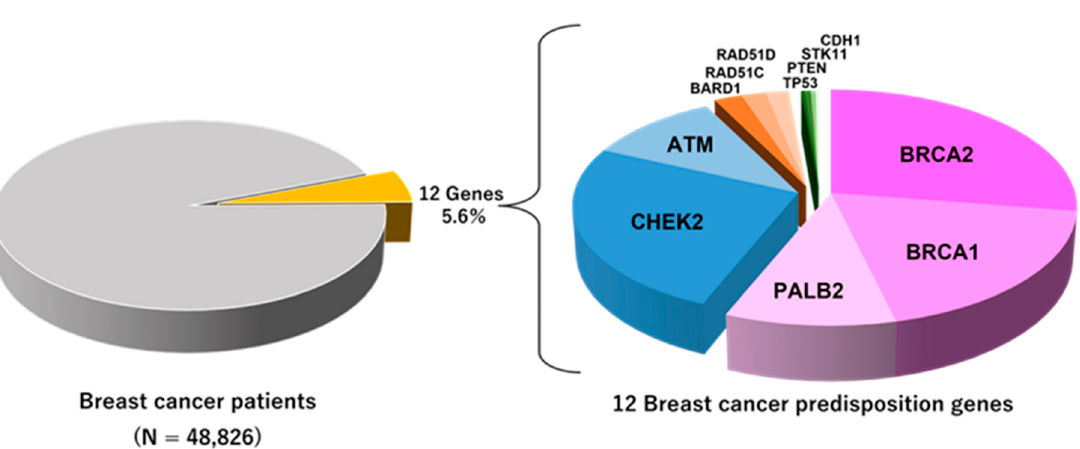
Figure 2. Frequency of protein-truncating variants in 12 breast cancer predisposition genes in the population-based study reported by Dorling et al. [12].